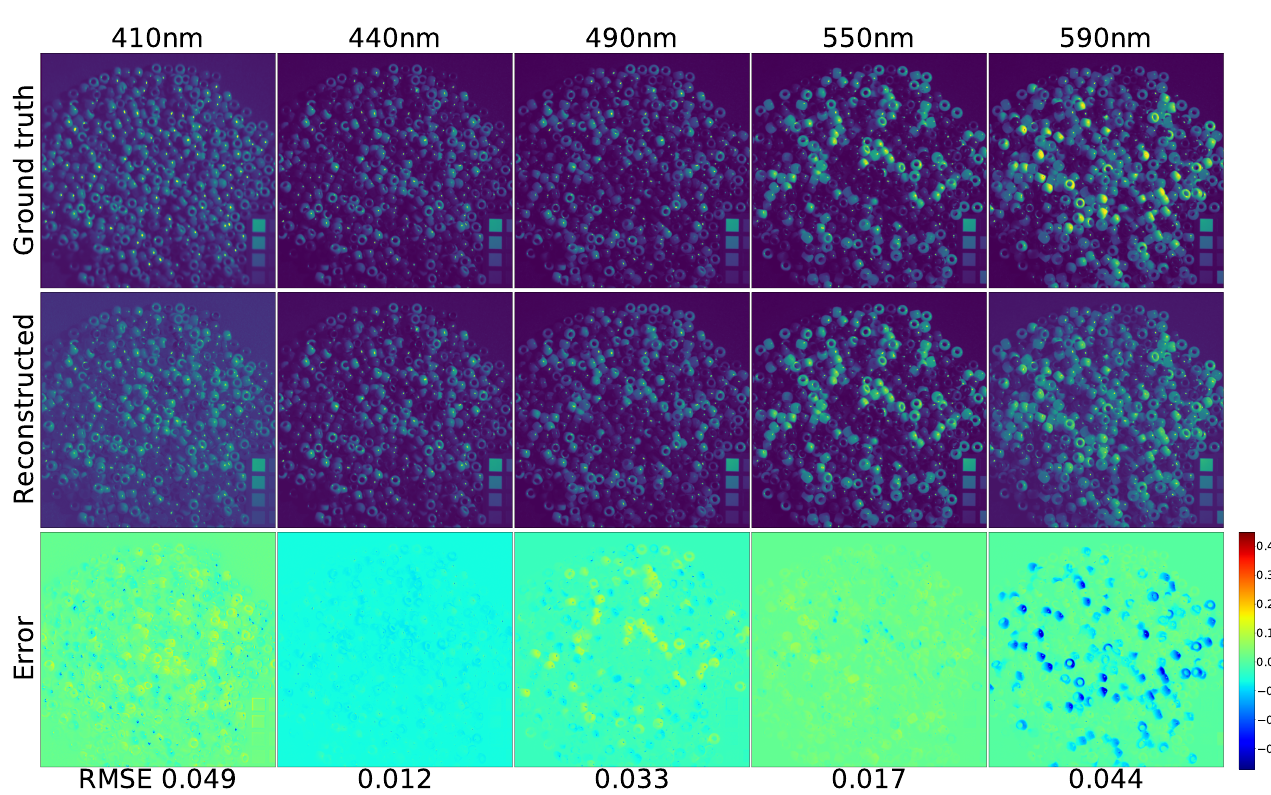
Figure 8. The effects of reconstructing the 5 chosen spectrum channels from an RGB image. (The original input RGB is shown in the top-left image of Figure 9).